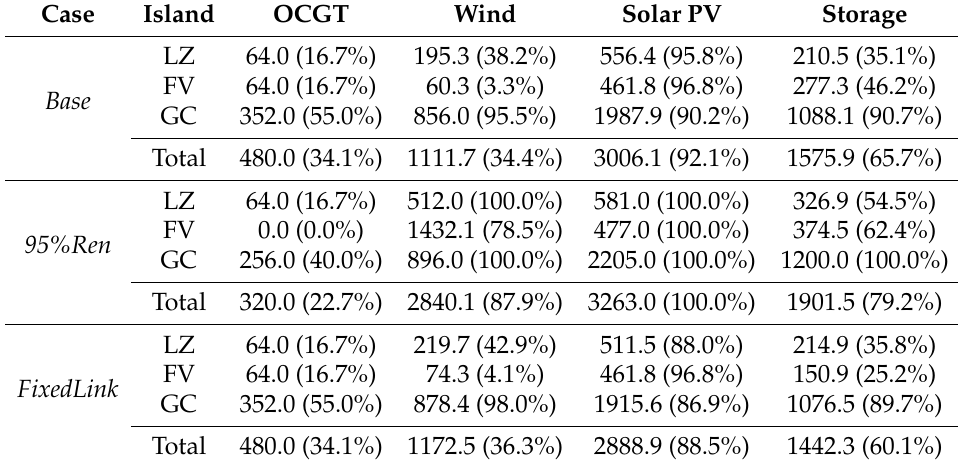
Table 12. Generation and storage capacity to be installed